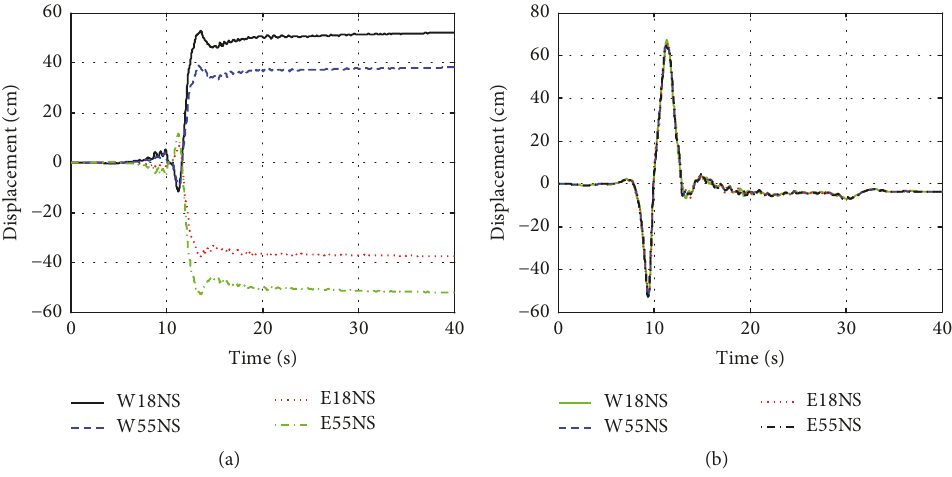
Figure 5: Simulated ground displacement: (a) parallel to the fault and (b) normal to the